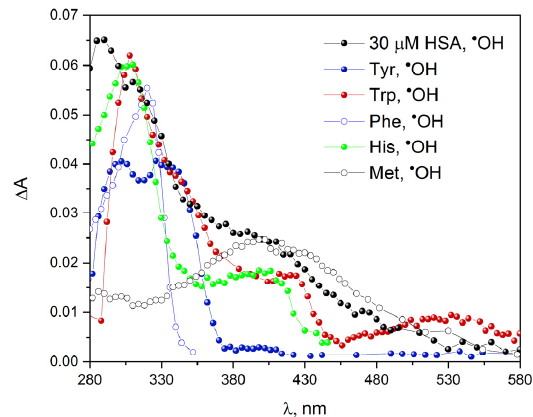
Figure 23. Transient absorption spectra of N 2 O-saturated buffer solutions containing 30 µM HSA,